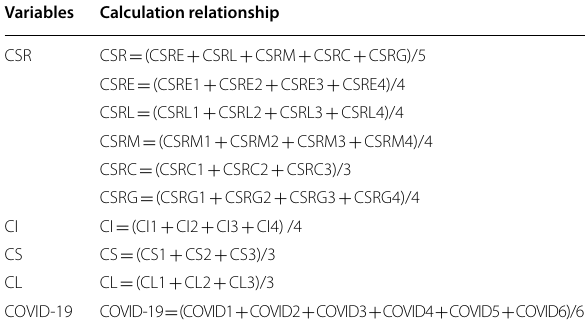
Table 2 Calculation relationship between variables Variables Calculation relationship